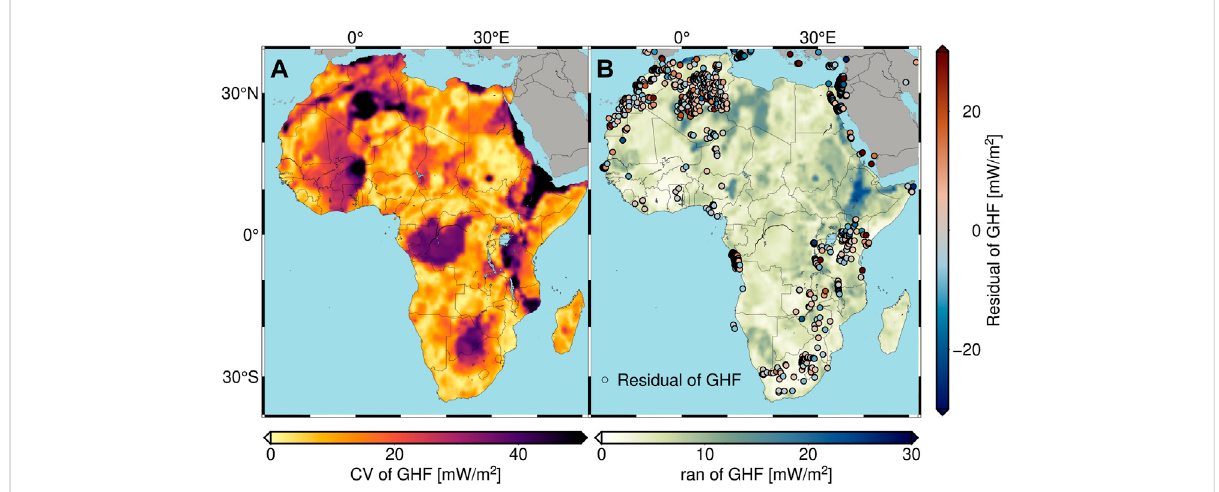
FIGURE 8 (A) Coef fi cient of variation for AFQ as de fi ned by “ CV ” in (3), indicating the deviation of the predicted heat fl ow from the African mean; (B) Variation of predicted heat fl ow as de fi ned by the quantity “ ran ” in (2), indicating the range of predicted heat fl ow values due to different numbers of observables used for training the random forest (a larger range means an increased variation among the different models). The residuals between reference GHF and the predicted values of AFQ (the fi nal model trained with eleven observables) are overlaid as